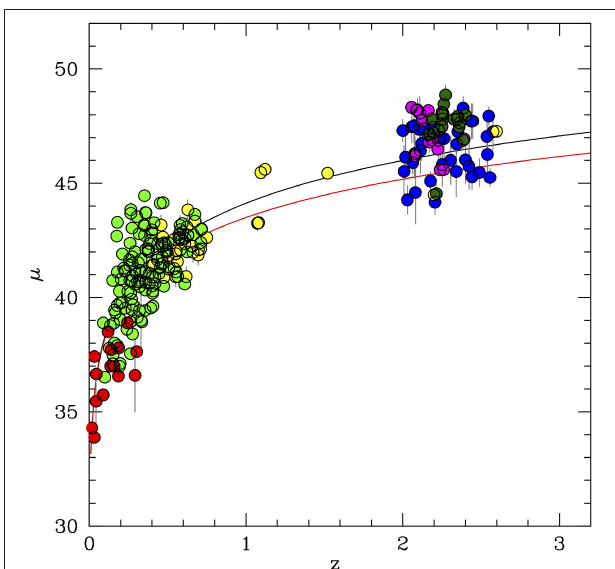
FIGURE 3 | Hubble diagram (distance modulus µ vs. redshift z ) for several samples of xA quasars using virial luminosity distances from the FWHM of H β and Al III λ 1860. Data points are color-coded according to sample and line employed: blue